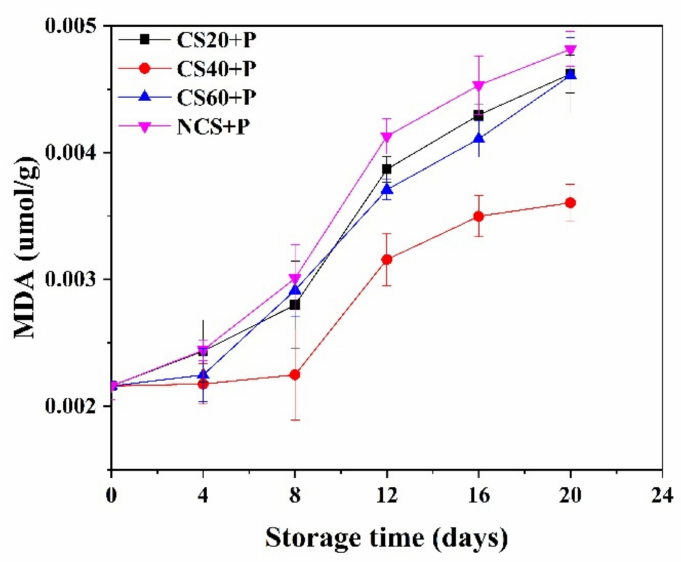
Figure 6. Effect of different treatments on the MDA content of cucumbers during storage at 13 ± 2 ◦ C. CS20+P − packaged after 20 min of cold shock; CS40+P − packaged after 40 min of cold shock; CS60+P − packaged after 60 min of cold shock; NCS+P − packaged after 0 min of cold